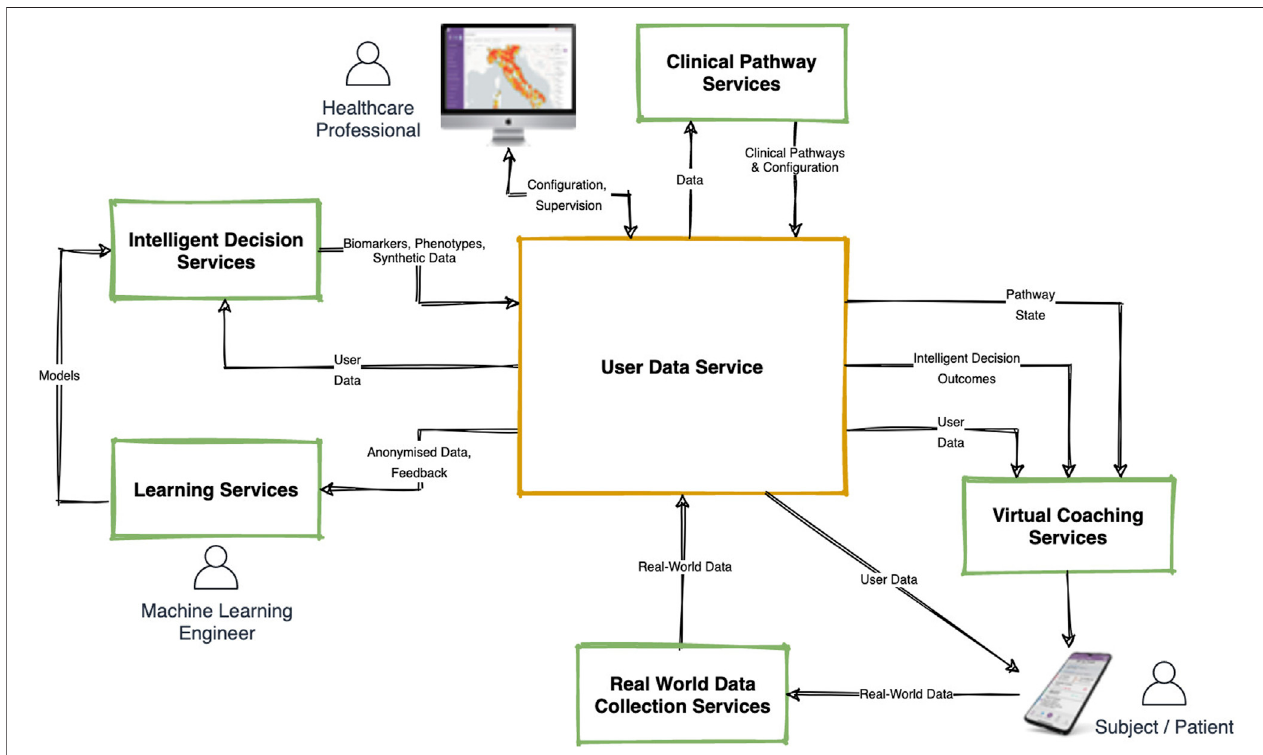
FIGURE 1 | High-level architecture of the proposed Digital Therapeutics